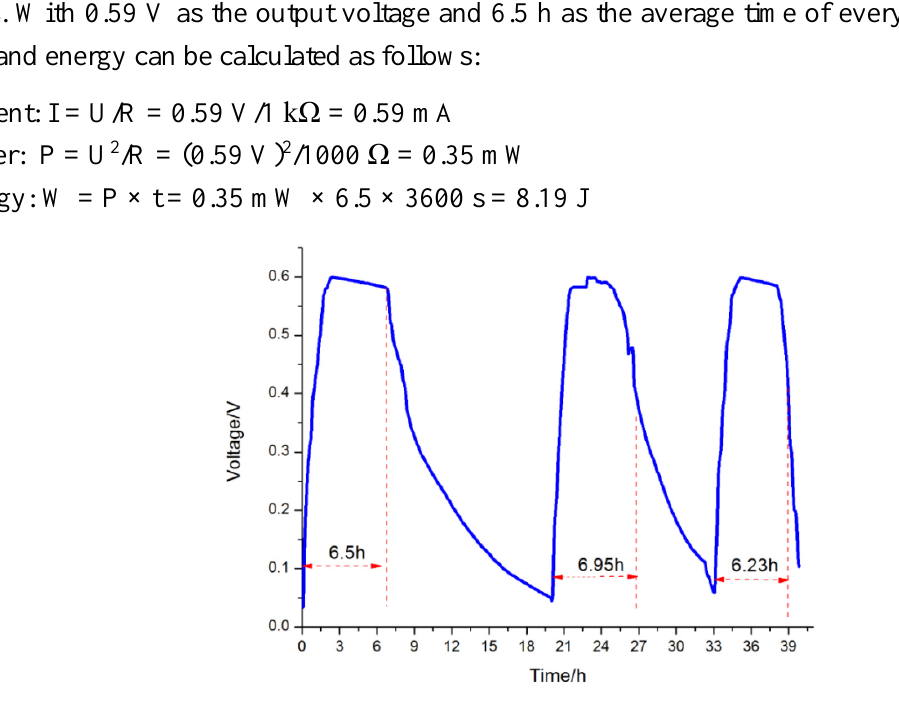
Figure 10. Three continuous flow cycles showing voltage variation at the external resistance of 1